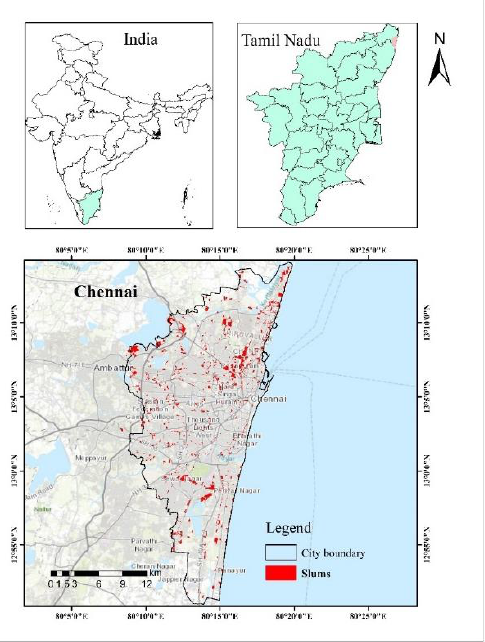
Figure 1. Study area Map